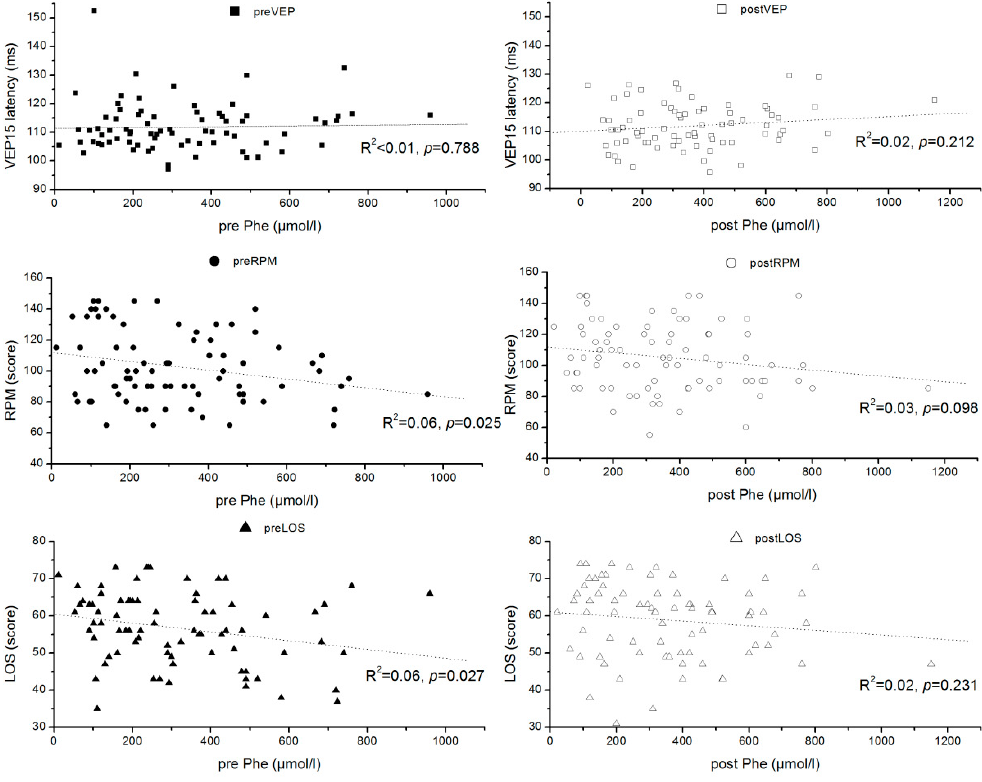
Figure 3. Association of the latency of visually evoked potentials with pattern size 15´ (VEP15 latency), the Ravens score (RPM), and the Lincoln-Oseretzky score (LOS) with the plasma phenylalanine (Phe) concentrations (µmol/L) before (pre) and after (post) intervention.